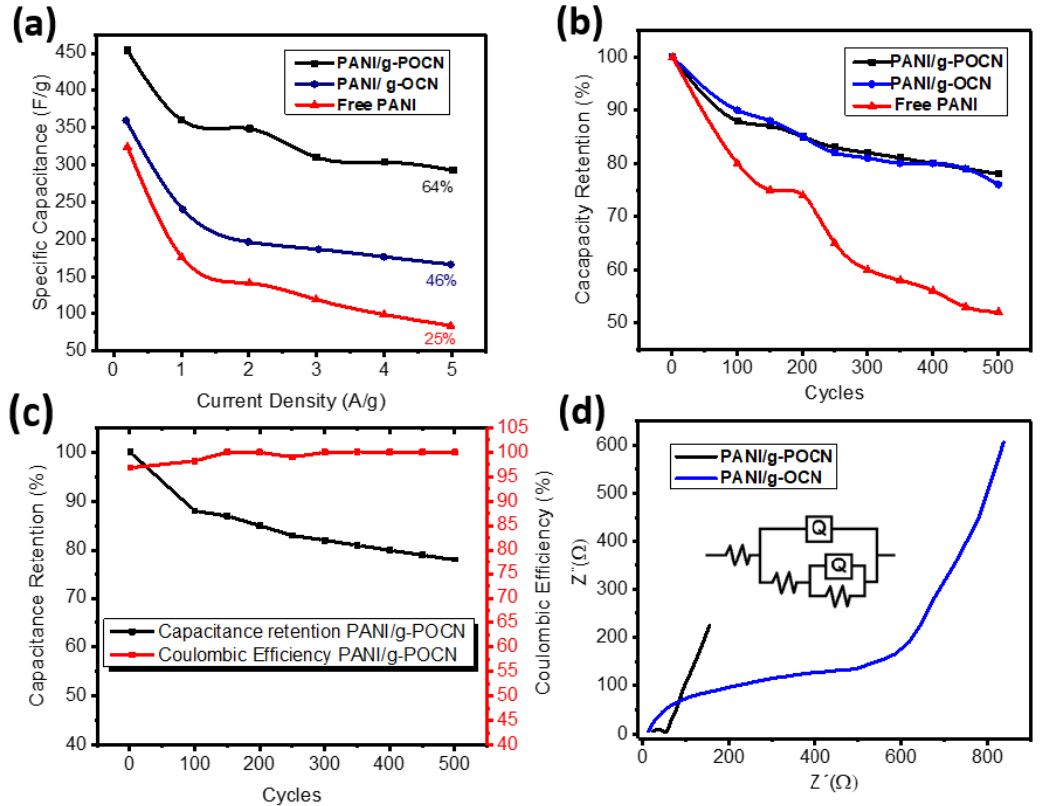
Figure 10. ( a ) Plot of C s vs. A/g for different currents applied to the materials PANI/g-OCN, PANI/g- POCN, and Free PANI. ( b ) Stability of materials after 500 galvanostatic charge-discharge cycles at 3 A/g. ( c ) Cycling stability performance and coulombic efficiency of PANI/g-POCN after 500 cycles. ( d ) Nyquist curves of Nanocomposites PANI/g-OCN and PANI/g-POCN with a fitted electrical equivalent circuit.